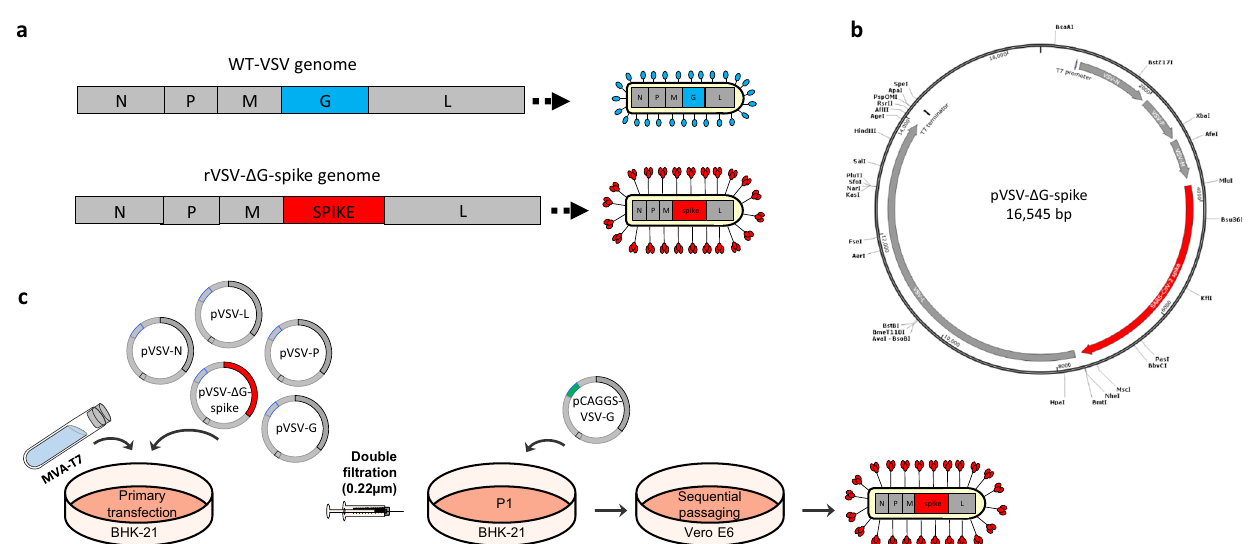
Fig. 1 rVSV- Δ G-spike design and generation strategy. a A schematic diagram of the genomic organization of WT-VSV (top diagram), and rVSV- Δ G- spike (bottom diagram). N nucleoprotein, P phosphoprotein, M matrix, L large polymerase, G glycoprotein, SPIKE SARS-CoV-2 spike. b pVSV- Δ G-spike map. c Schematic representation of the generation process of rVSV- Δ G-spike vaccine. Infection of BHK-21 cells with MVA-T7, followed by cotransfection with pVSV- Δ G-spike, and VSV-system accessory plasmids; transfection of BHK-21 cells with pCAGGS-VSV-G, followed by infection with the supernatant of the primary transfection, to create P1; sequential passaging in Vero E6 cells were performed creating rVSV- Δ G-spike.